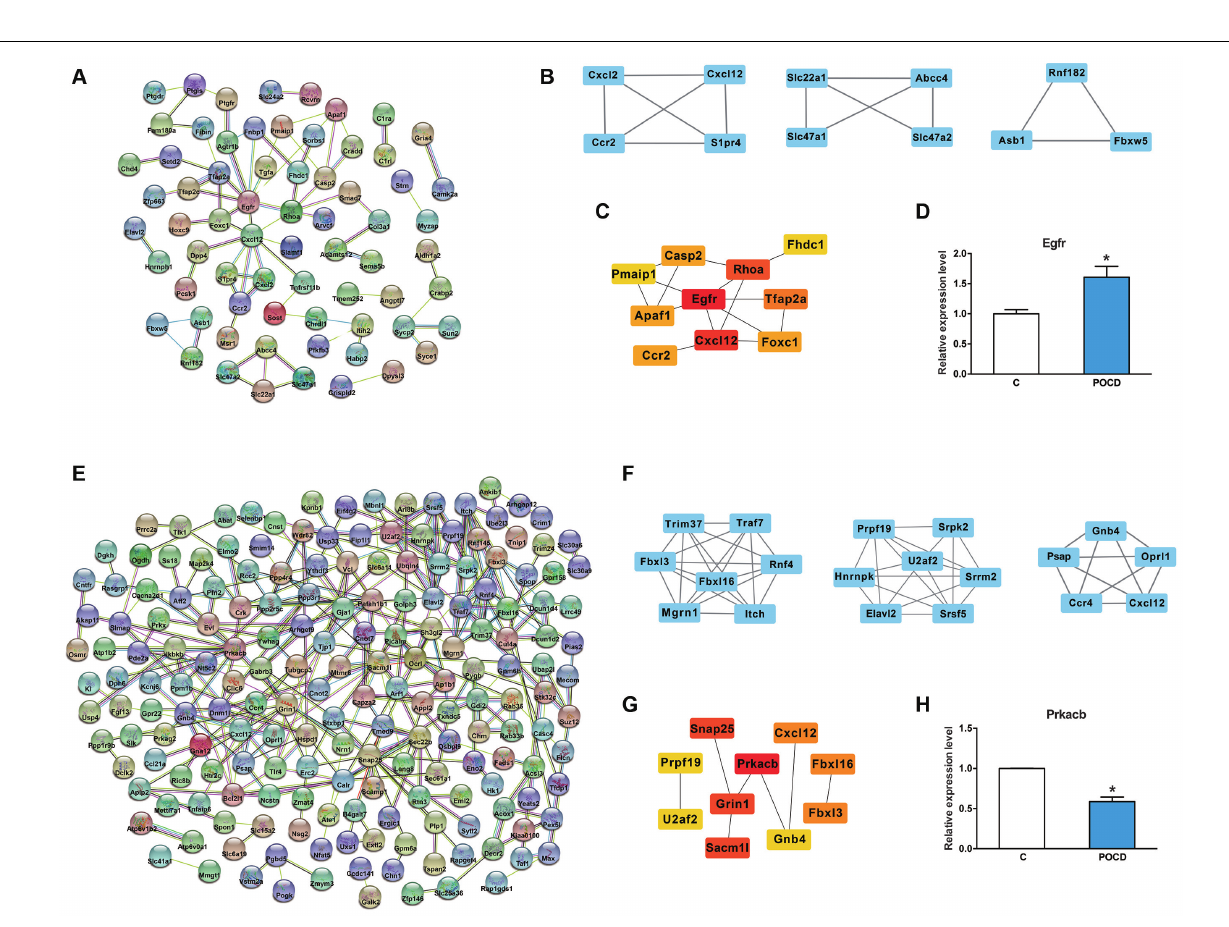
FIGURE 6 | Protein-protein analysis of circRNAs regulated genes. (A,E) The protein-protein interaction network analysis for the up/downregulated genes. (B,F) Top three sub-network modules that are predicted by MCODE in the Cytoscape software. (C,G) Top 10 hub genes screened by CytohHubba in the Cytoscape software. (D,H) The mRNA expression level of Egfr and Prkacb validation. * p < 0.05 compared with the control